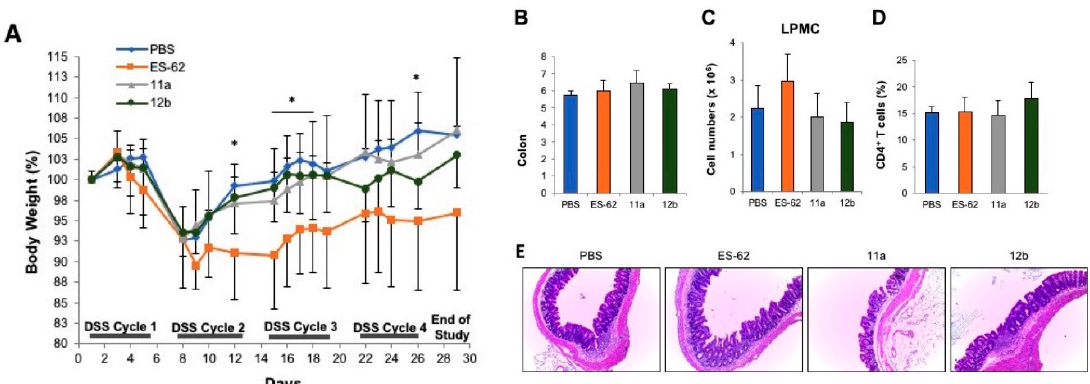
Figure 6. ES-62, and SMAs 11a and 12b do not prevent the induction of chronic colonic inflammation in the DSS-colitis model. ( A ) Body weight changes (as percentage of the initial weight) from the initiation of DSS-colitis was measured during four cycles of DSS with thrice weekly treatments of ES-62 or SMAs (11a or 12b). ( B ) Colon length (cm) was measured at cull. ( C ) Total cell counts and the proportion of CD4 + T cells ( D ) present in the lamina propria mononuclear cells (LPMC) were measured. ( E ) Representative Heamatoxylin and Eosin (H & E) staining of colons at time of sacrifice. Magnification = 100 × . Data in ( A – D ) represent the means ± SD ( n = 5) and statistical significance as determined by student’s t test (PBS versus ES-62) is denoted by * p < 0.05.